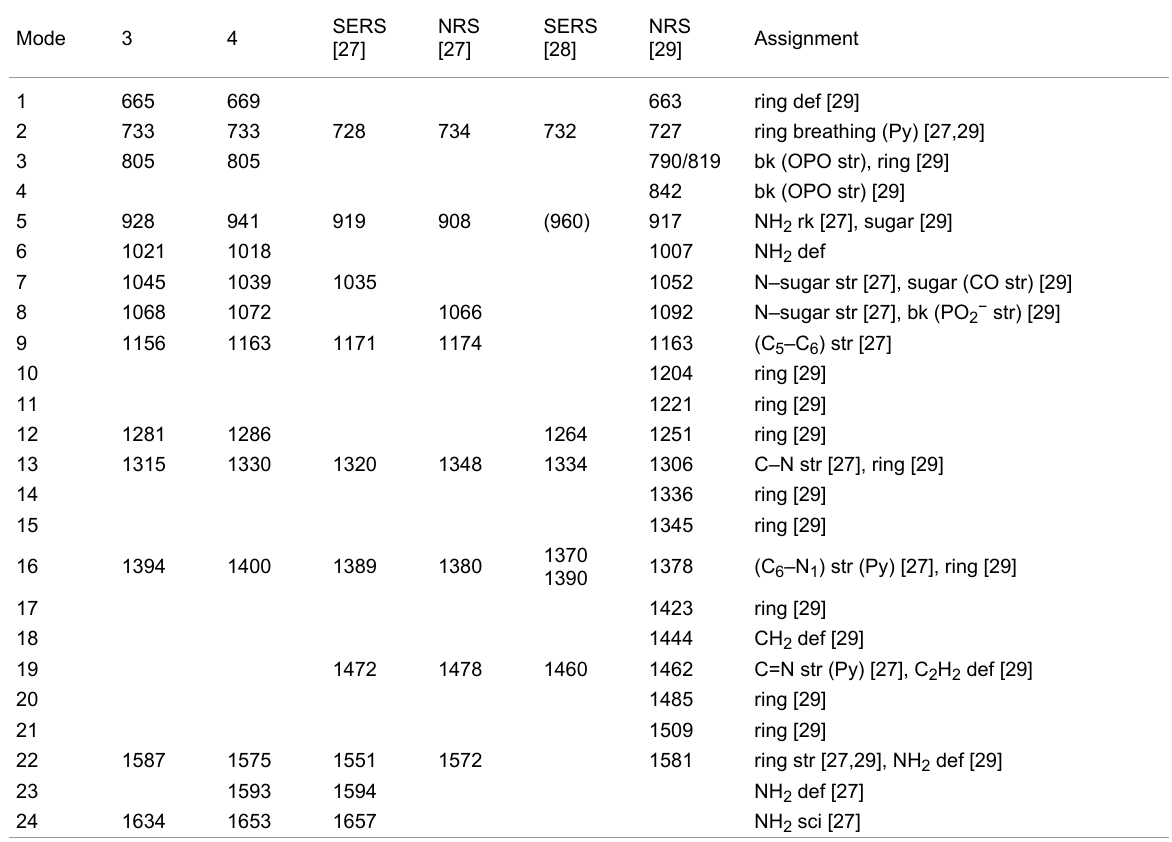
Table 1: Band assignment of the TERS spectra of the adenine homopolymer (in cm − 1 ). a